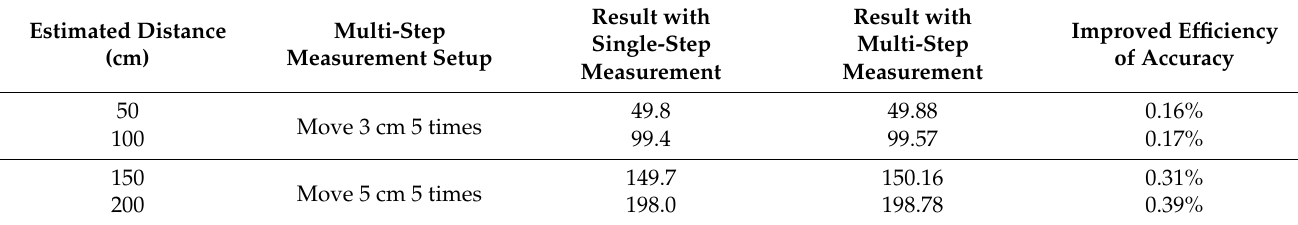
Table 6. Estimated results using the ultrasonic sensor module